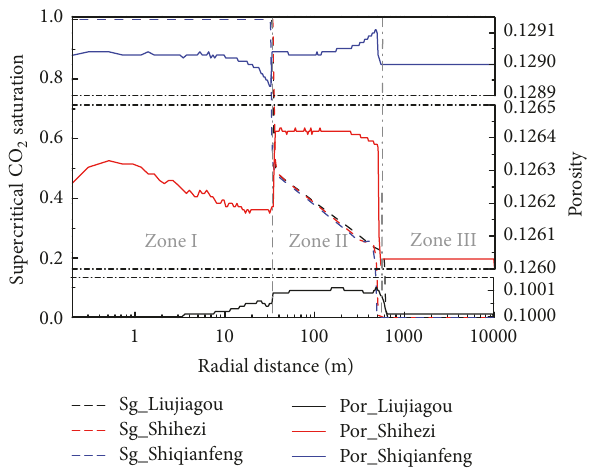
Figure 8: The distribution of porosity and supercritical CO 2 saturationinthehorizontalplaneatthedepthof − 75 mafter30years of CO 2 injection in the three